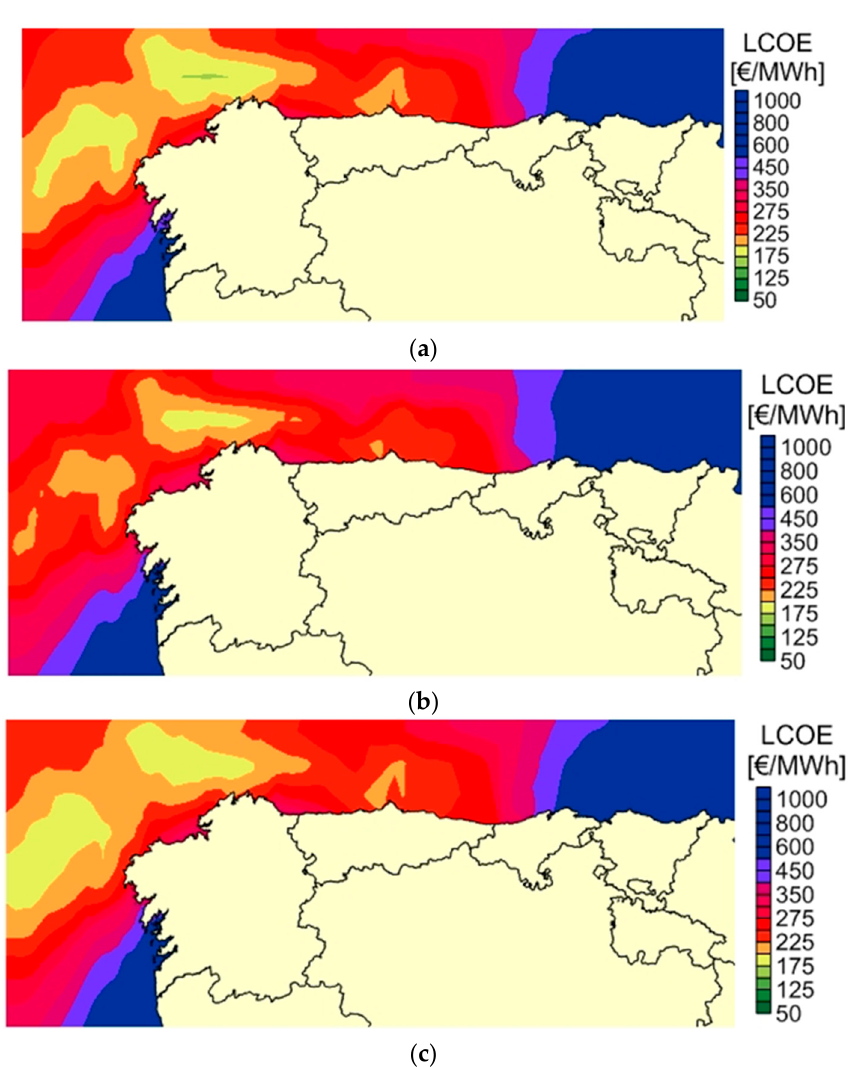
Figure 10. Results for LCOE without restrictions for semisubmersible ( a ), tensioned leg platform ( b ), and spar ( c ).